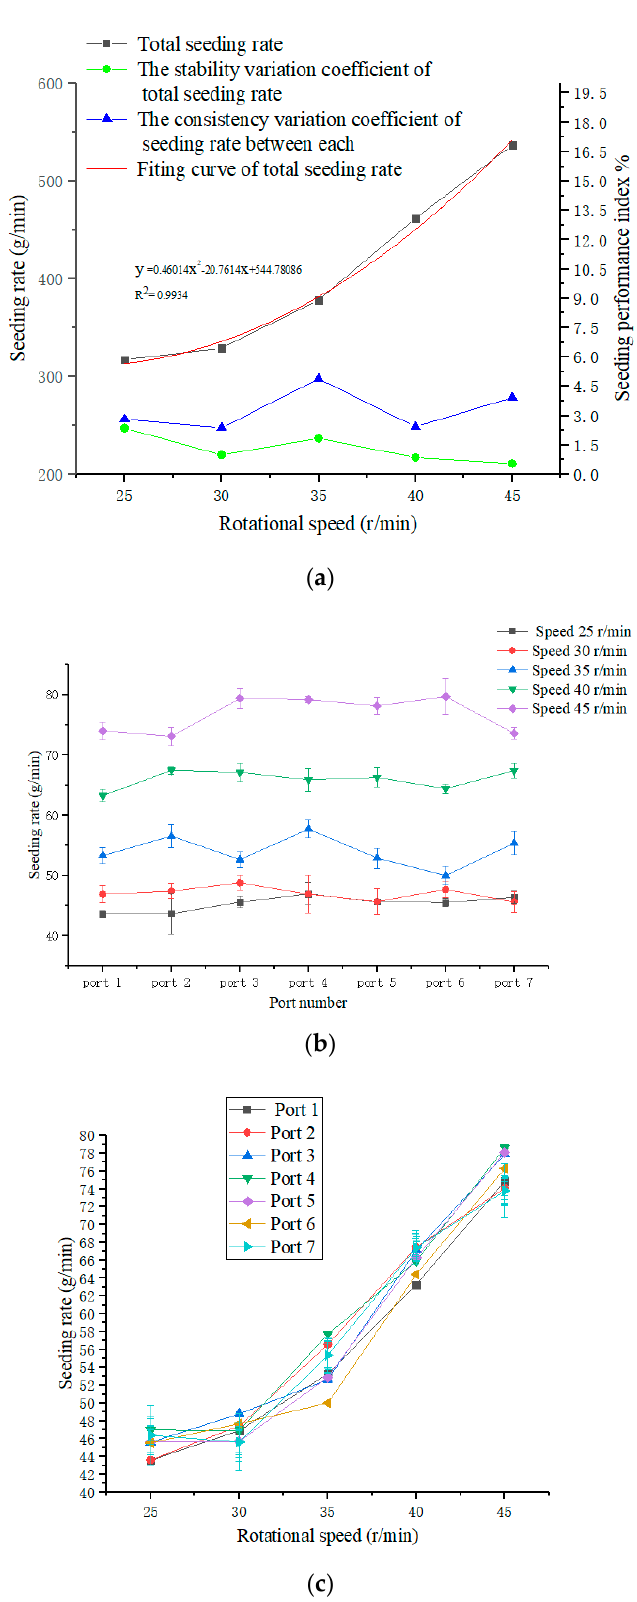
Figure 7. Seeding performance. ( a ) Total seeding rates and variation coefficients with respect to the rotational speed of the gear disc; ( b ) Comparison of seeding rates of each port; ( c ) Variations of seeding rates of each port with respect to the rotational speed of the gear disc.